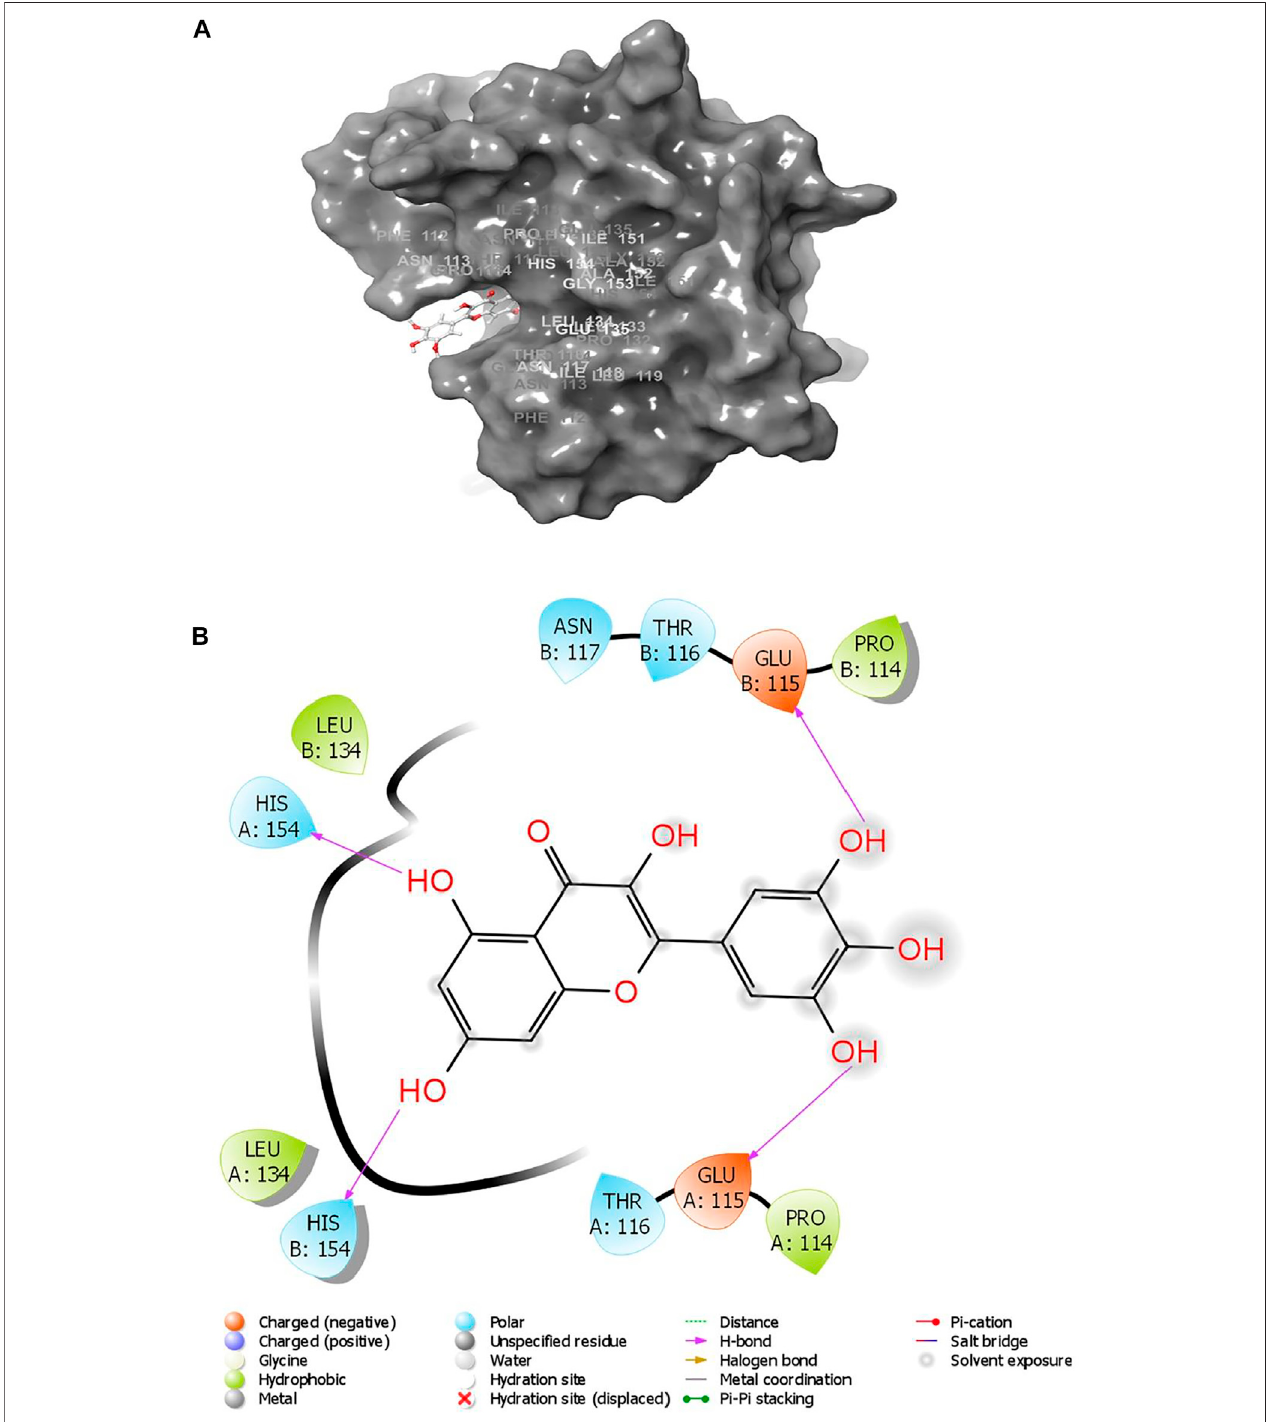
FIGURE1|(A) SurfaceviewoftheinteractionsbetweenSARS-CoV-2M Proteinbound tothe ligandZIN1722; (B) Detailed interactiondiagram ofSARS-CoV-2M Protein with ZIN 1722. [before MD simulation].